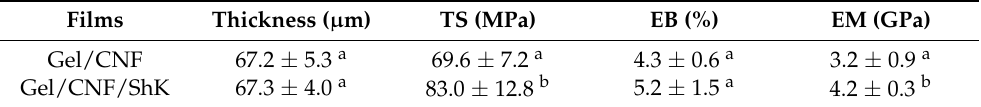
Figure 5. TGA and DTG thermograms of the smart film. Table 2. Mechanical properties of